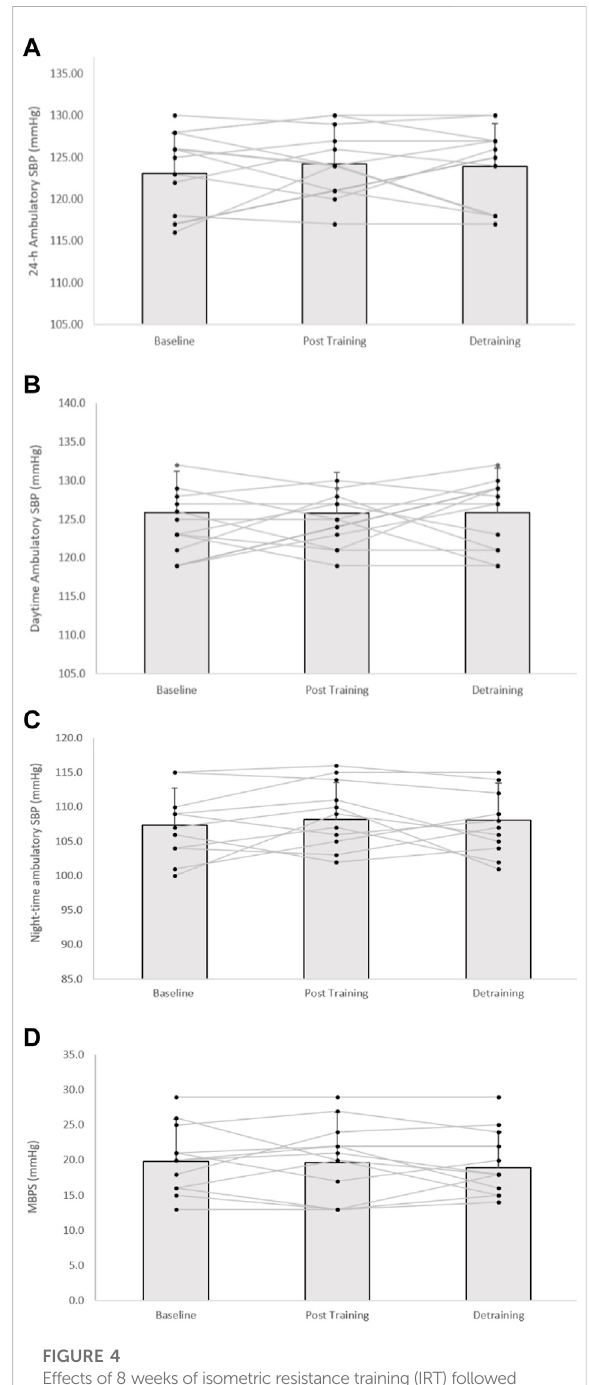
FIGURE 4 Effects of 8 weeks of isometric resistance training (IRT) followed by 8 weeks of detraining for individual participants and mean data on (A) , 24-h (B) , daytime (C) , Night-time ambulatory systolic blood pressure(SBP)and (D) ,morningbloodpressuresurge(MBPS)for control (CON) groups. * p value < 0.005, ** p value < ambulatory DBP or DBP ARV at the end of the IRT programme (mid-point) or following the detraining period ( p > 0.05 in both cases; see Figure 5; Table 2).